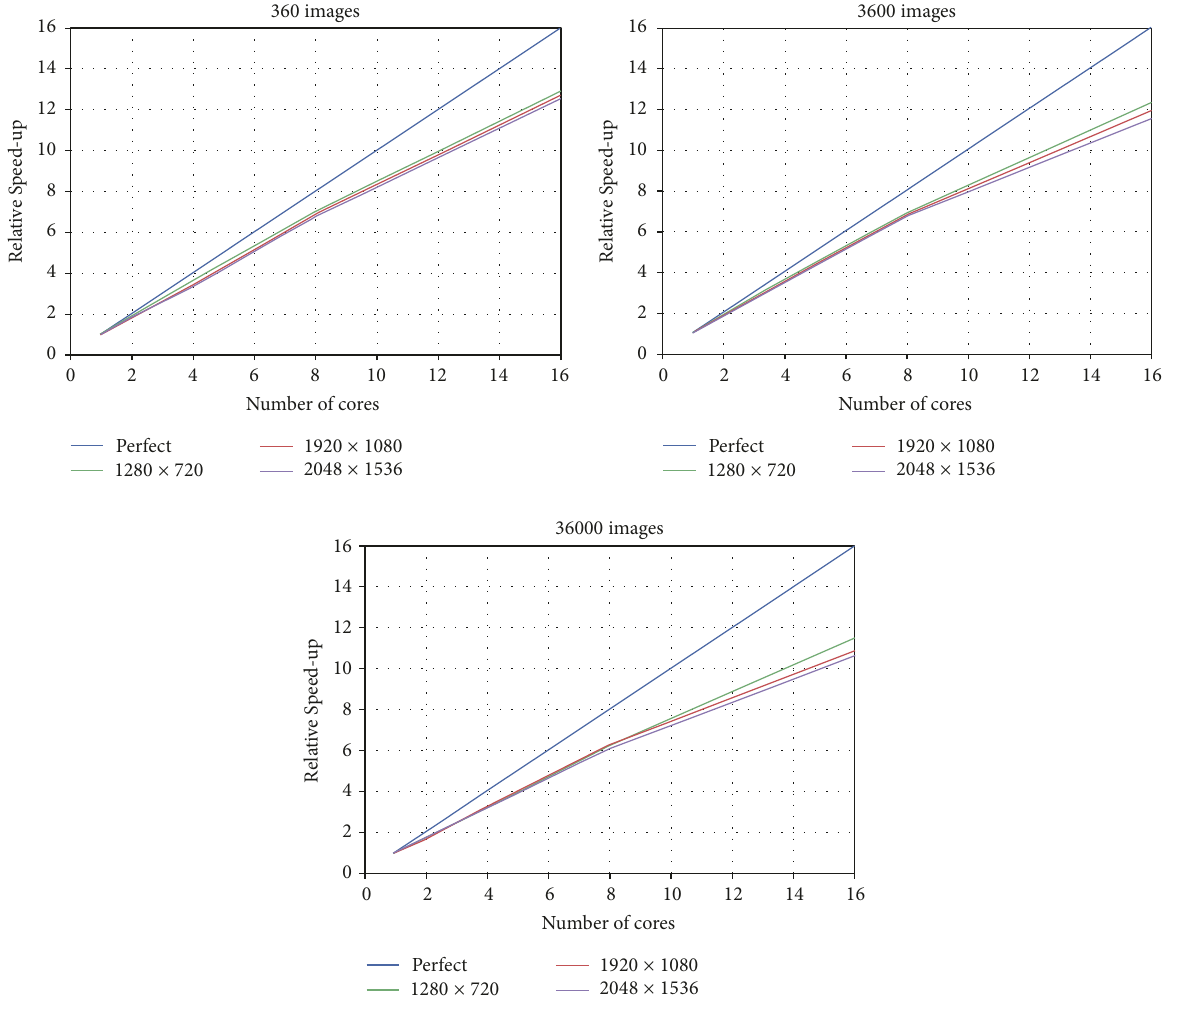
Figure 16: Relative speed-up